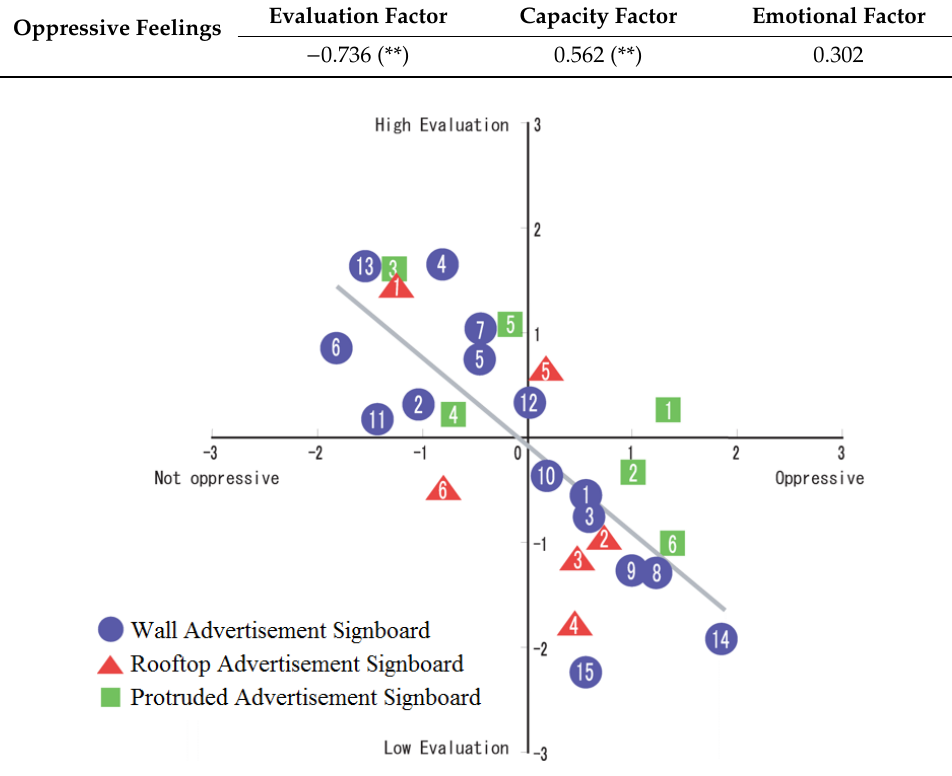
Figure 7. Scatter diagram of correlations based on the oppressive feeling and evaluation factor values.